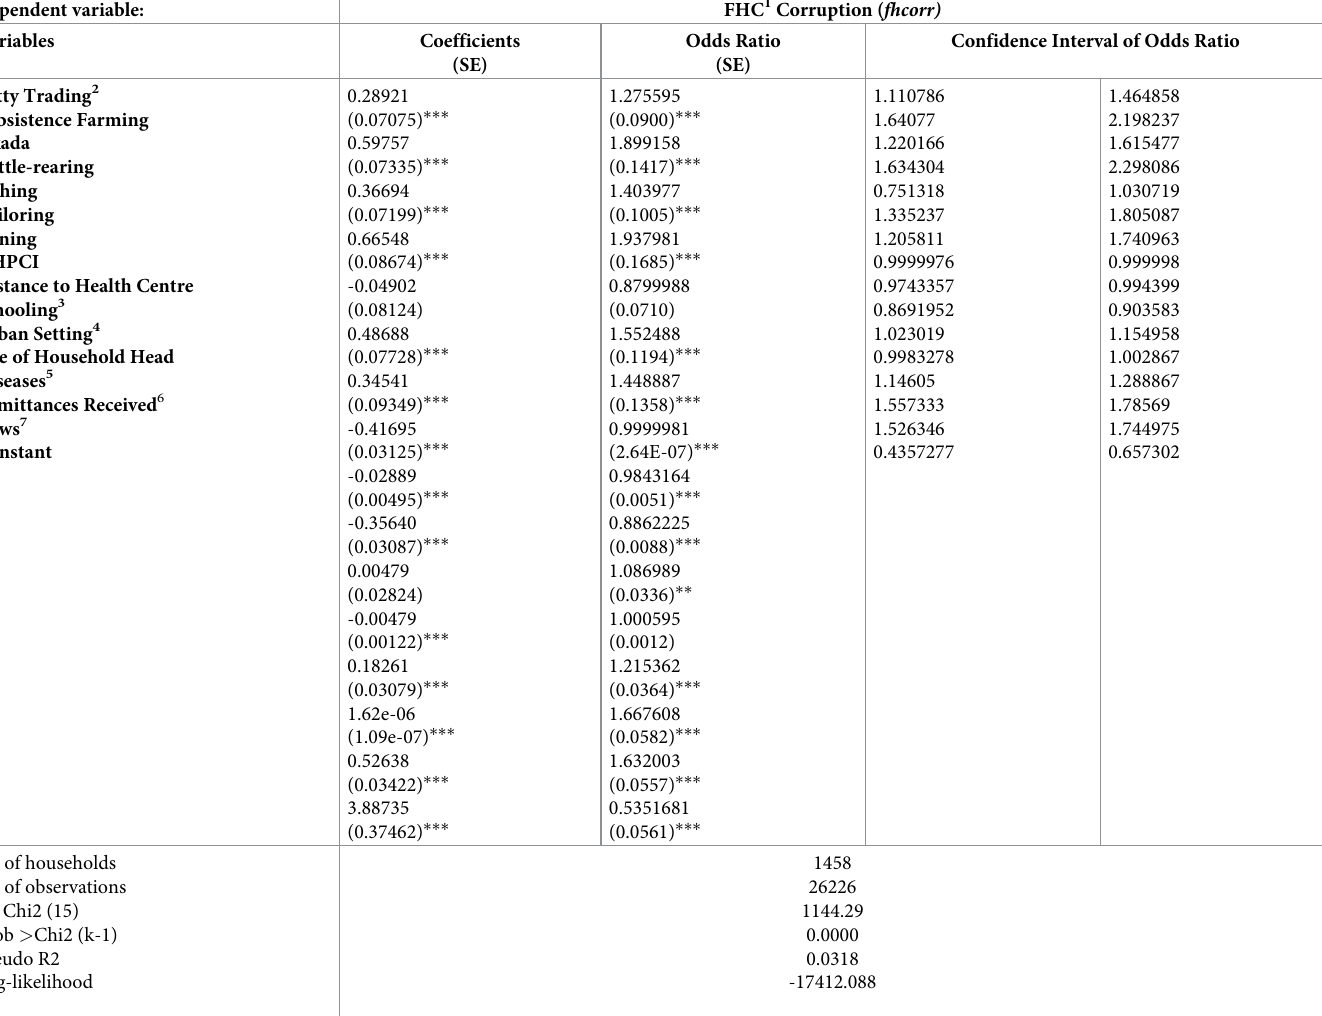
Table 4. Relationship between experienced corruption and household characteristics–logit. Dependent